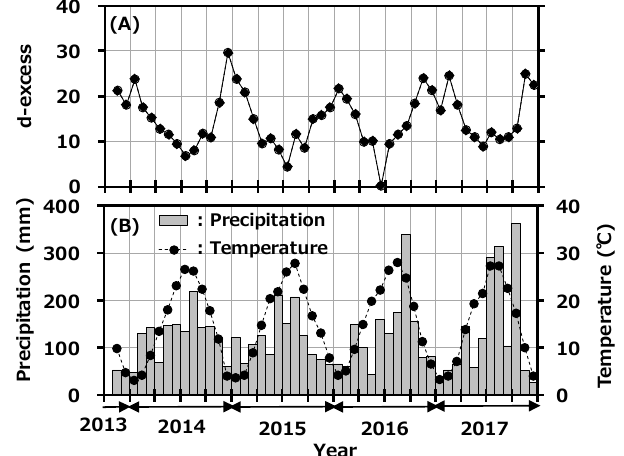
Figure 4. Relationship between δ D and δ 18 O in monthly precipitation collected at Toki, Japan and a plot of the global meteoric water line.